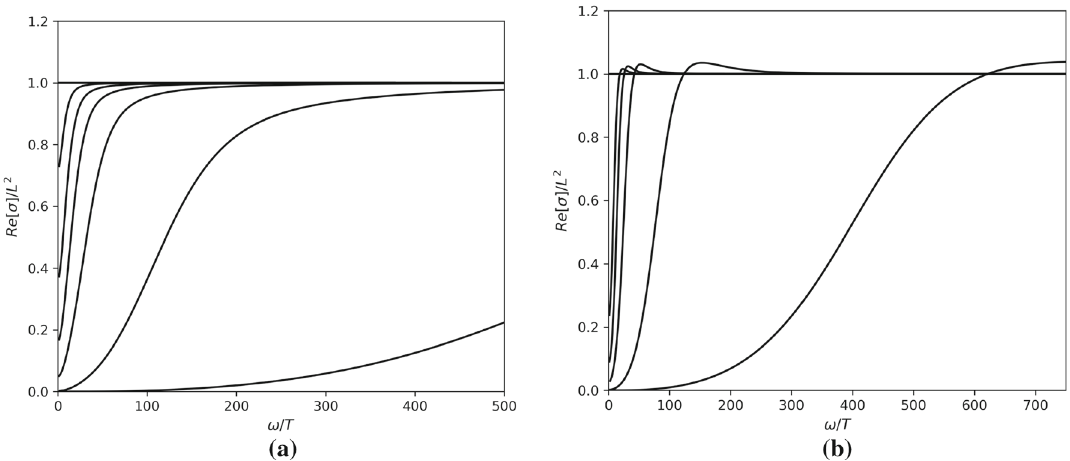
Fig. 6 The evolution of Re σ (ω) versus ω/ T at ε = 4 π, Q = L = 1 for O 1 (a) and O 2 (b). Each graph, from left to right, is plotted for T / T c = 0.9, 0.7, 0.5, 0.3, 0.1 and 0.02 respectively